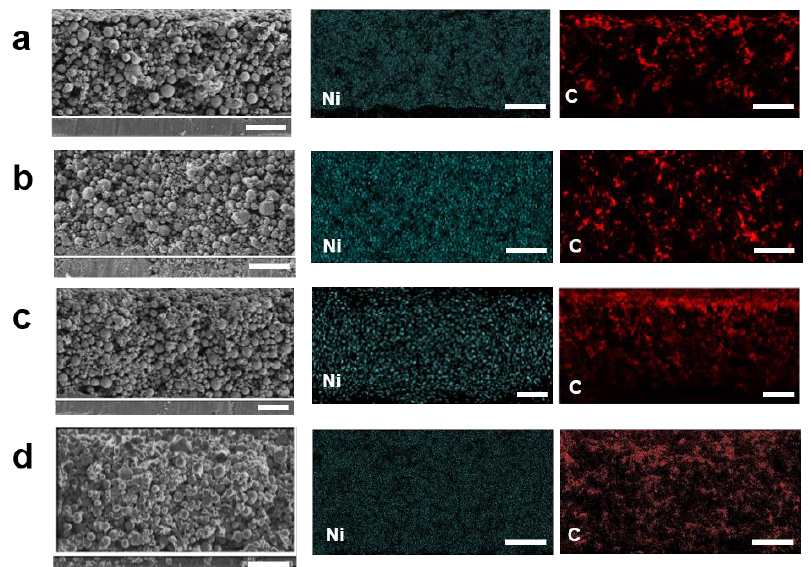
Figure 6. Cross-sectional SEM image and EDS mapping of electrode surface of ( a ) wet PVDF, ( b ) dry PVDF, ( c ) wet phenoxy resin, and ( d ) dry phenoxy resin. Scale bar = 50 μm. Ni and C elemental distribution are indicated by cyan and red, respectively.